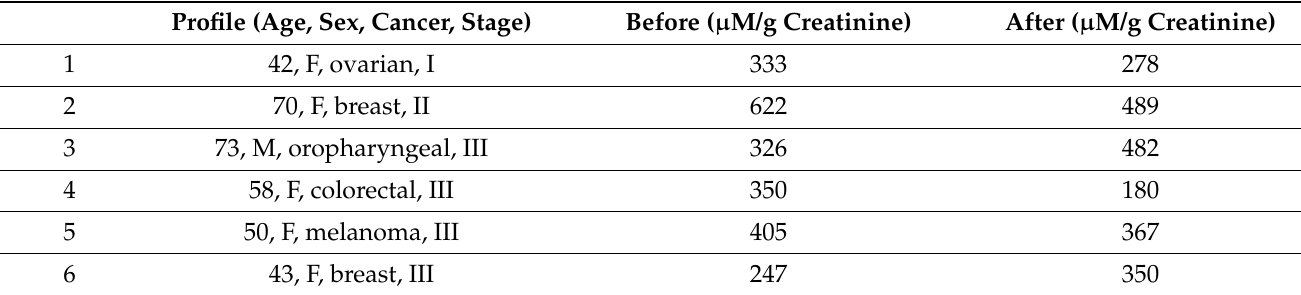
Table 1. The change in urinary indoxyl sulfate concentration ( µ M/g creatinine) after oral administration of capsules containing a Si-based agent and water-soluble dietary fiber in cancer patients after one month. Profile (Age, Sex, Cancer,